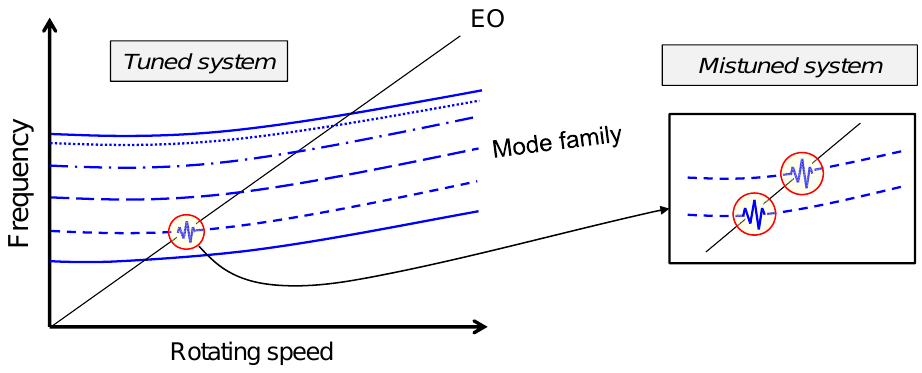
Figure 4. Splitting frequency in a mistuned system.